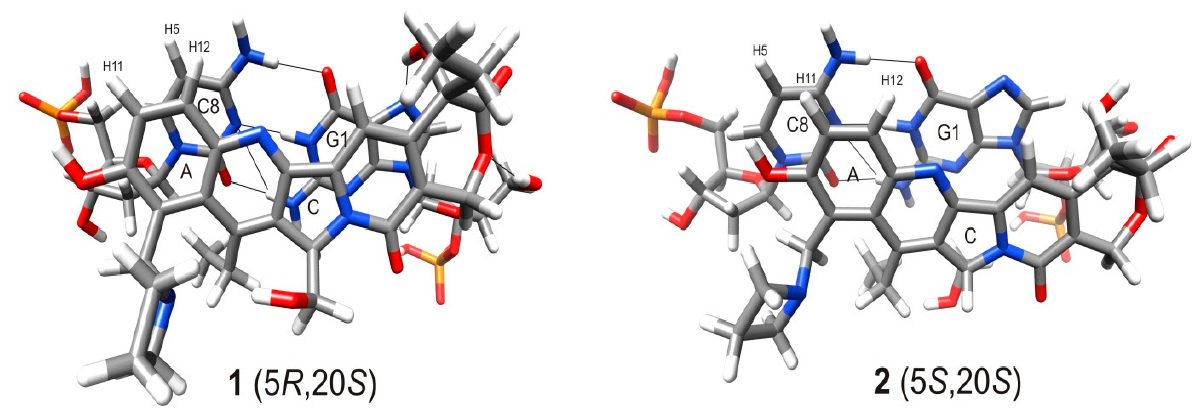
Figure 8. Molecular model of MD of the most abundant structures of the complexes of the ultimate base pair G1-C8 of a self-complementary duplex d(GCGATCGC) 2 with diastereomers 1 (see Table 6, No. 1) and 2 (see Table 7, No. 1). For both structures, the hydrogen bonds of the base pairs and intermolecular C20-OH to N7 of the imidazole ring are shown. The additional intermolecular hydrogen bonds in the structure R-1 are shown between the CH 2 O H of G1 2 ′ -deoxyribose and C16a carbonyl. Table 7. Diastereomer 2 C5( S ), PM7 clusters energies.